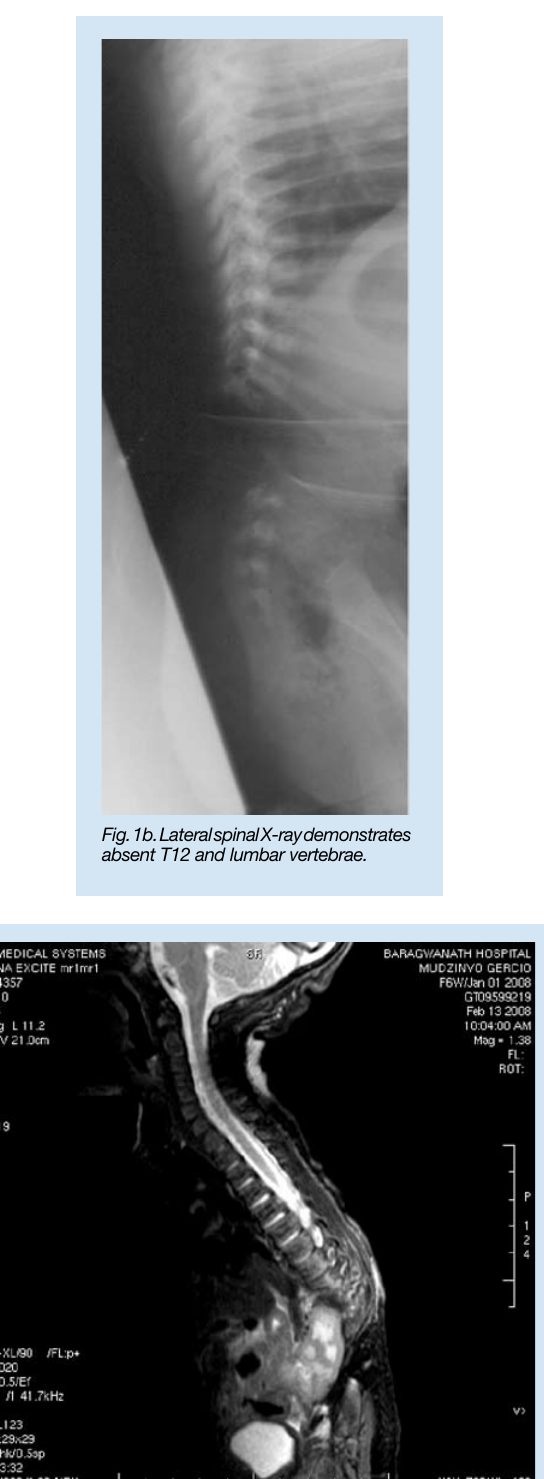
Fig. 2a. Saggital T2 MRI demonstrates spinal cord hypoplasia with disconnection of the spinal segments above and below the dysgenetic T12 segment at thoracic level 6, with the bony vertebrae terminating at T10, and complete aplasia of T12. The sacrum and pelvis are normally developed.